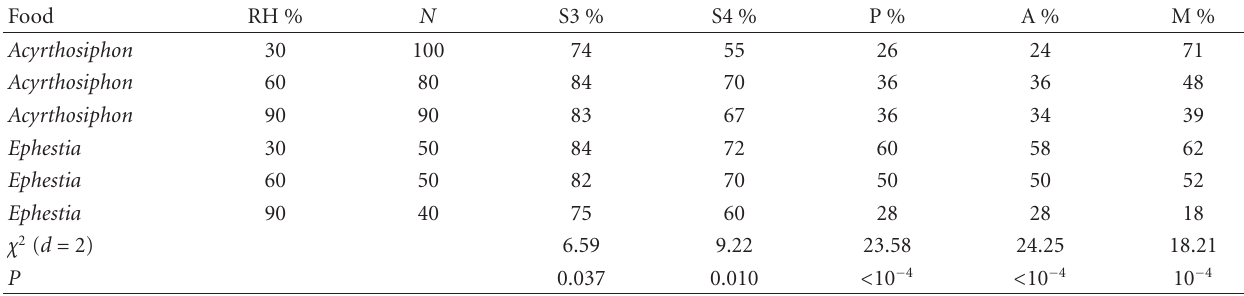
Table 1: Survival of developmental stages of Harmonia axyridis reared on two diets and in three levels of relative air humidity at 25 ◦ C and 16L:8D photoperiod. N : initial number of second instar larvae, S3, S4, P and A: percentage survival to particular larval instar, pupal, or adult stage relative to the initial number of individuals, M: sex ratio (percentage of males). Chi-square tests with their probabilities were calculated for three-dimensional contingency table (food × humidity ×